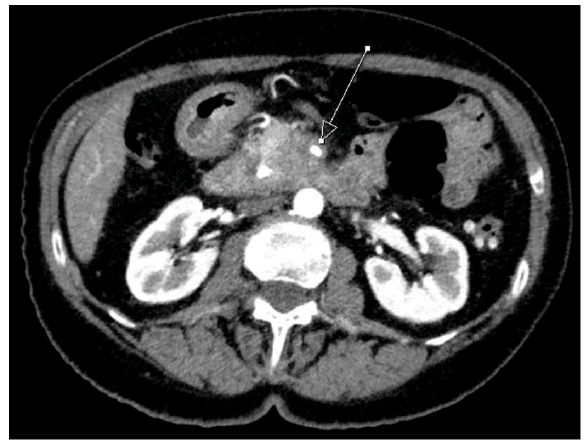
Figure 1. Computed tomography image of a tumor in the pancreatic head which surrounds the superior mesenteric artery (arrow: “unresectable”).